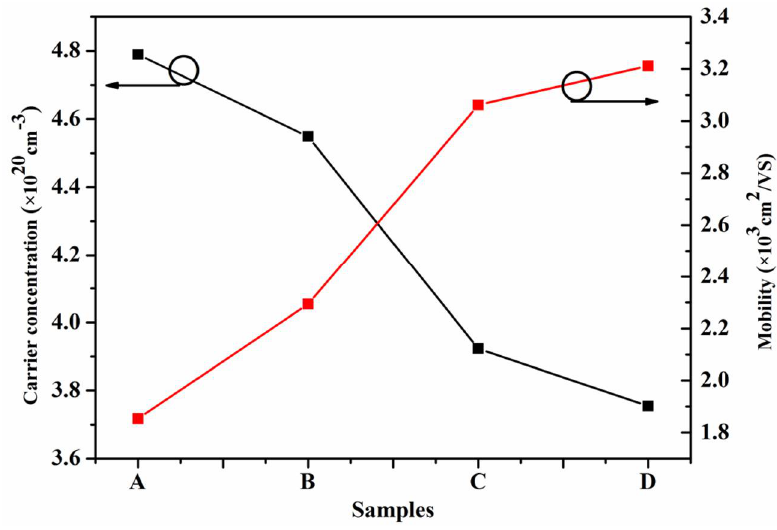
Figure 6. Variation of the mobility and carrier concentration of the In 0.82 Ga 0.18 As epitaxial layers grown on InP (100) substrates.